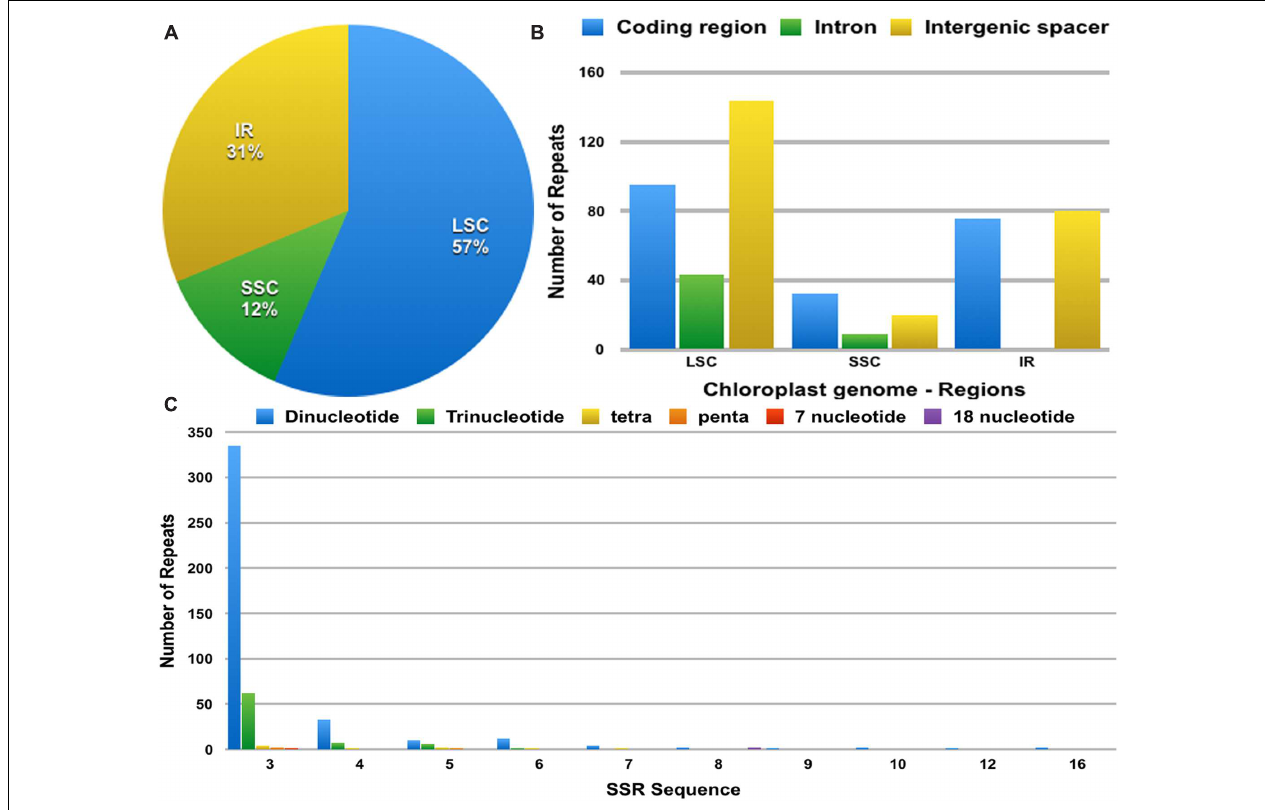
FIGURE 4 | The distribution, type and presence of simple sequence repeats (SSRs) in the cp genome of Ampelopsis brevipedunculata . (A) Presence of SSRs in the LSC, SSC, and IR regions. (B) Presence of SSRs in the protein-coding regions, intergenic spacers and introns of LSC, SSC, and IR regions. (C) Presence of polymers in the cp genome of A. brevipedunculata .